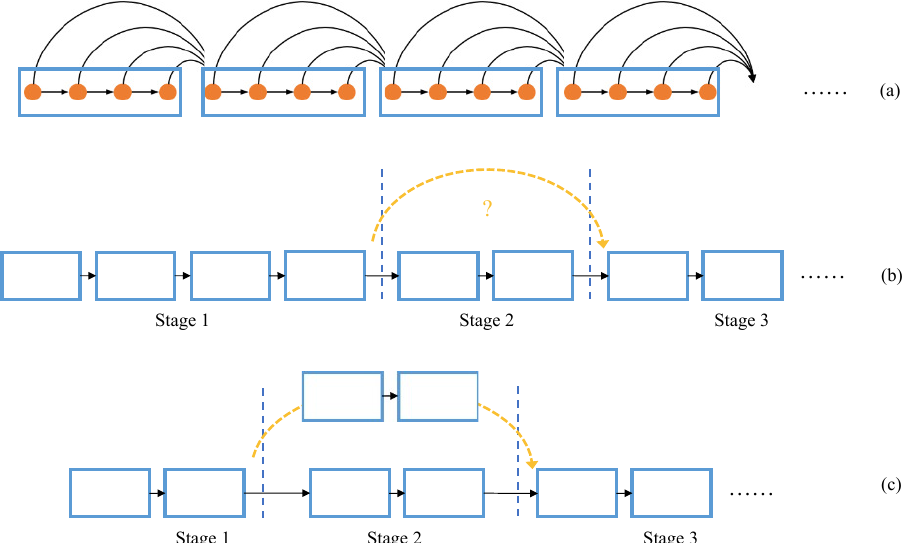
Figure 5. ( a ) STDC-Seg backbone, ( b ) split connection motivation, ( c ) our backbone. The orange circle denotes the convolutional layer, the blue rectangles denote the individual STDC blocks, and the yellow connection denotes the split